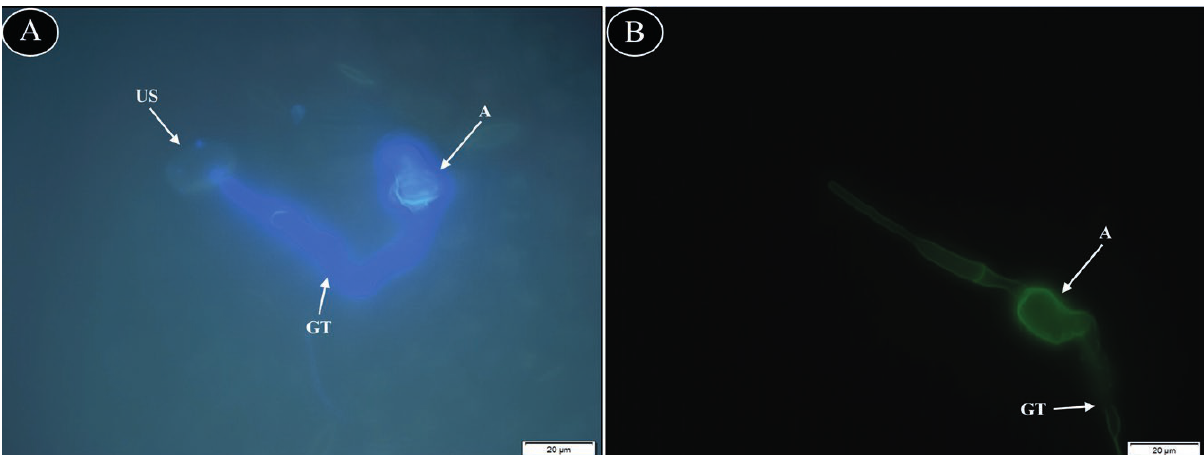
Figure 4. Microscope images of Phakopsora nishidana urediniospore germination, taken at 96 h post-inoculation, from A, Queensland Red mulberry leaf, indicating an early abortion, and B, mulberry, showing a non-penetrating appressorium. The urediniospore (US), germ tubes (GT) and appressoria (A) are indicated.